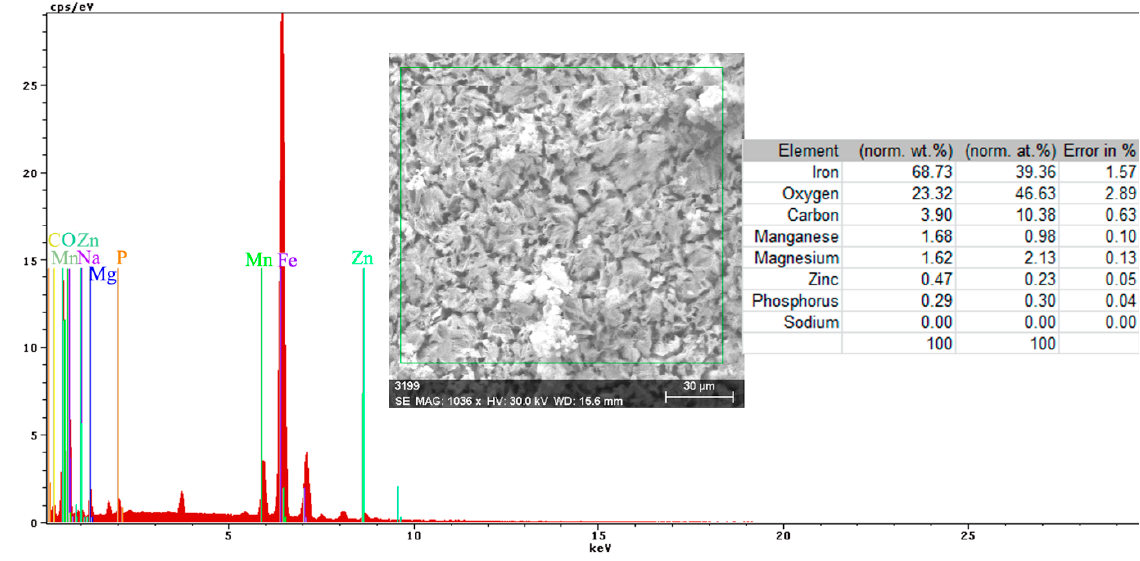
Figure 13. Energy spectrum and surface composition of the crust in the B zone of the PS sample maintained for 85 days in BSW.